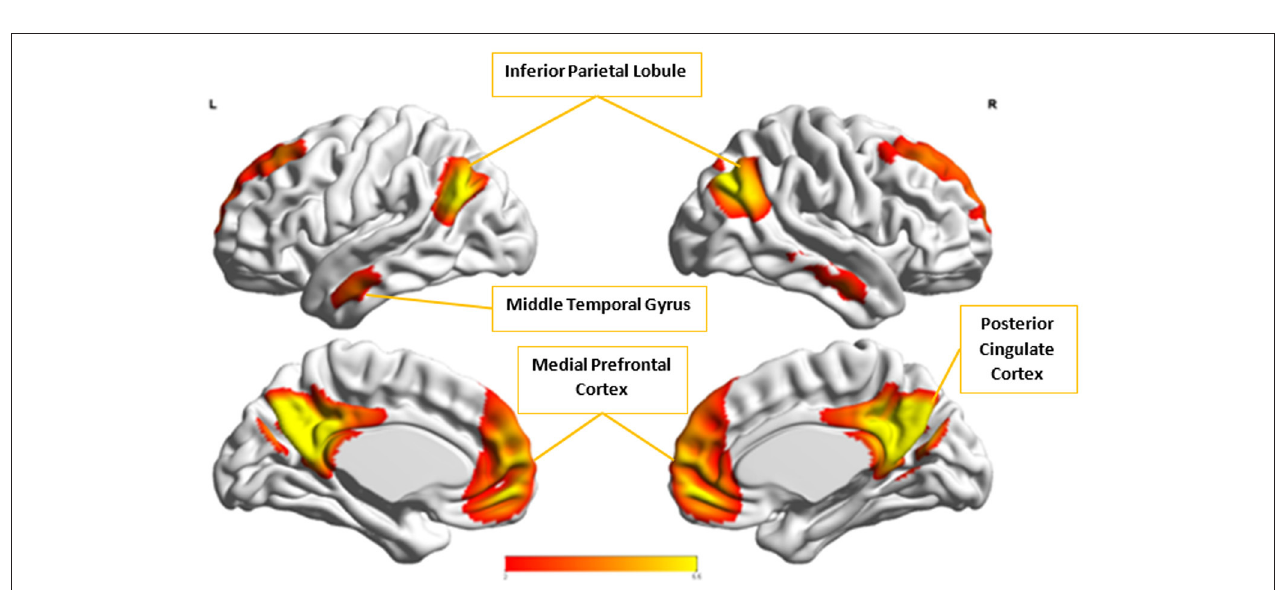
FIGURE 8 | The group-level component, A x , from Autism group that produced the highest cluster purity value of 0.971 when combined with another group-level component from the Control group, C x .